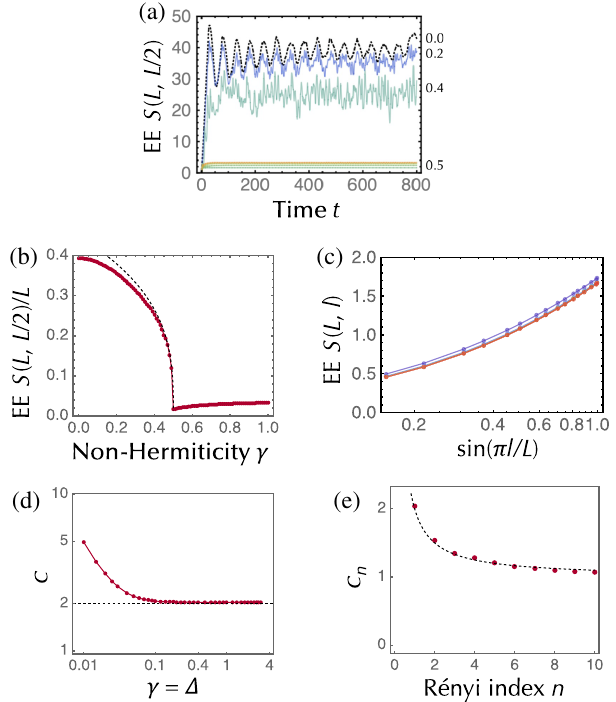
FIG. 14. Entanglement entropy of the symplectic Hatano- Nelson model with periodic boundaries ( L ¼ 100 , J ¼ 1 . 0 ). The initial state is prepared as Eq. (24). (a) Time evolution of the entanglement entropy S ð L; L= 2 Þ ( Δ ¼ 0 . 5 ) for γ ¼ 0 . 0 (black dashed curve), 0.2 (blue curve), 0.4, 0.5, 0.6 (green curves), 0.8 (orange curve), and 1.0 (red curve). (b) Entanglement entropy density S ð L; L= 2 Þ =L for the steady state as a function of non- Hermiticity γ ( Δ ¼ 0 . 5 ). The black dashed curve is the fitting result S ð L; L= 2 Þ =L ¼ 0 . 56 ð Δ =J − γ =J Þ 0 . 33 around the critical point γ ¼ Δ . (c) Entanglement entropy S ð L; l Þ for the steady state at the critical point ( γ ¼ Δ ) as a function of the subsystem length l for γ ¼ 0 . 0 , 0.1, 0.2, 0.4, 0.6, 0.8, and 1.0. (d) Effective central charge c as a function of γ at the critical point ( γ ¼ Δ ). The black dashed line shows c ¼ 2 . (e) c n obtained from the R´enyi entanglement entropy S ð n Þ ð L; l Þ for the steady state at the critical point ( γ ¼ Δ ¼ 1 . 0 ) as a function of the R´enyi index n . The black dashed curve shows the conformal field theory result c c ð 1 þ 1 =n Þ = 2 with c ¼ 2 n ¼ We confirm that our numerical results for the steady states are consistent with this subextensive behavior [Fig. 14(c)].